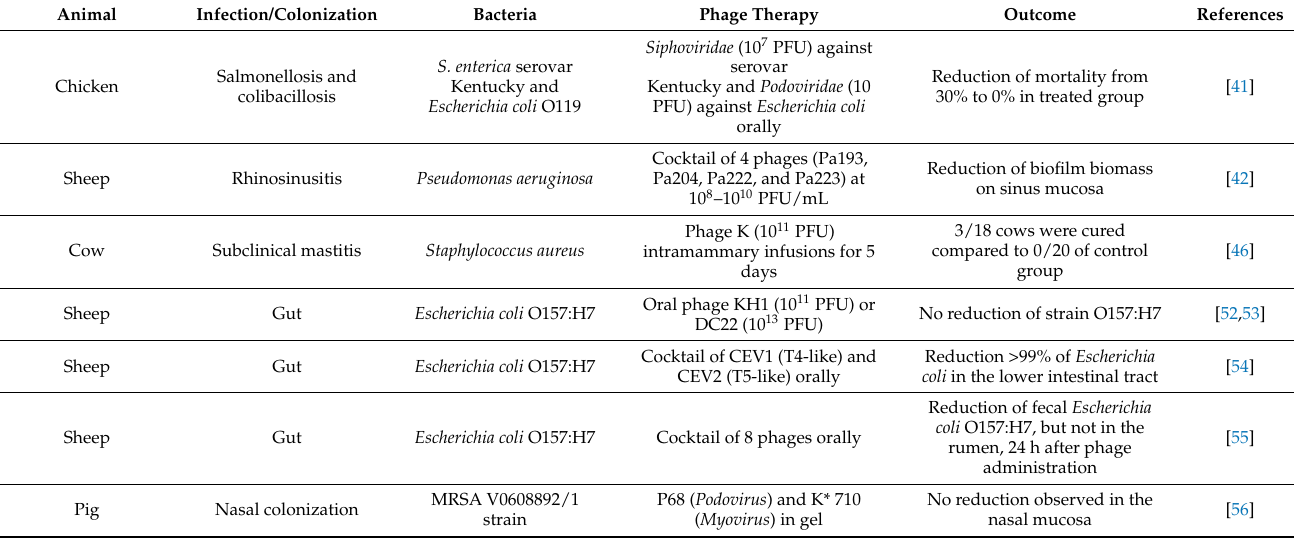
Table 2. Summary of reviewed studies using phage therapy in